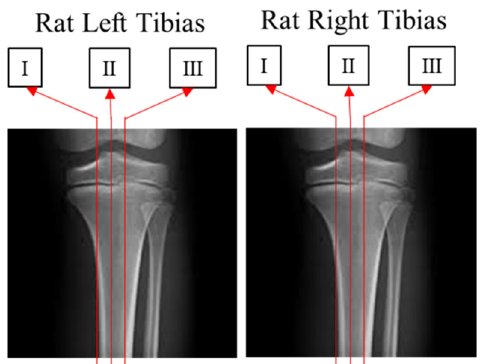
Figure 3. Three parts (I, II, III) of the left and right tibias.